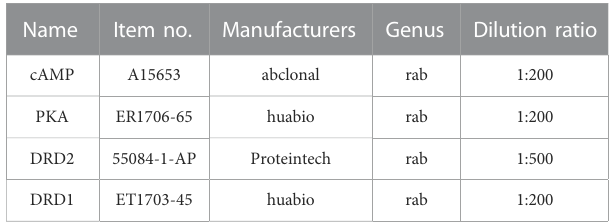
TABLE 1 Antibody information. TABLE 2 qPCR primer